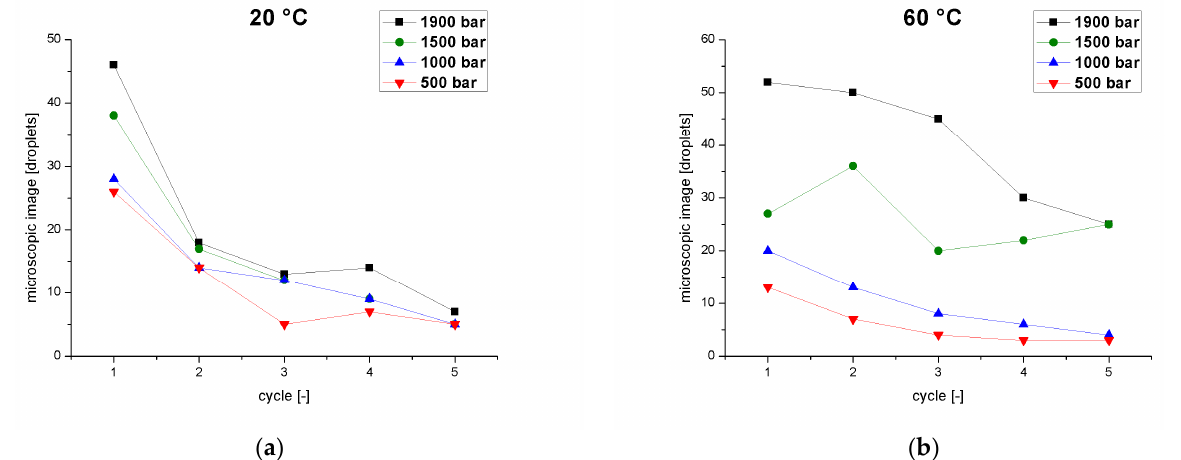
Figure 5. Droplet count determined by microscopy as a function of the number of cycles at different operating pressures (500–1900 bar) and two different temperatures. ( a ) Emulsion temperature at the inlet of the homogenizer = 20 °C. ( b ) Emulsion temperature at the inlet of the homogenizer = 60 °C.